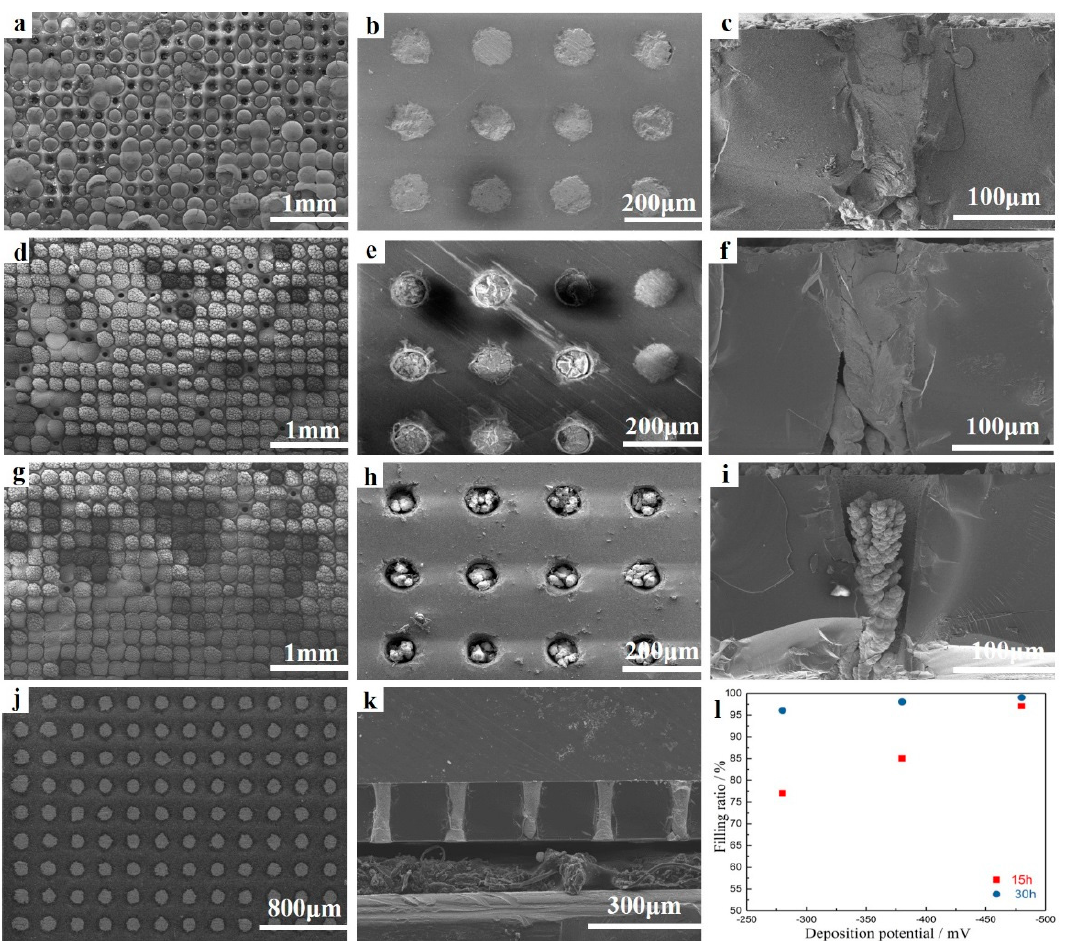
Figure 8. Top-and side-view SEM images of Sb-Te pillars deposited in a glass template at the deposition parameters of ( a – c ) − 280 mV, 15 h; ( d – f ) − 380 mV, 15 h; ( g – i ) − 480 mV, 15 h; and ( j , k ) − 280 mV, 30 h. ( l ) The filling ratio in micro-pores at the condition of different deposition potential and time.